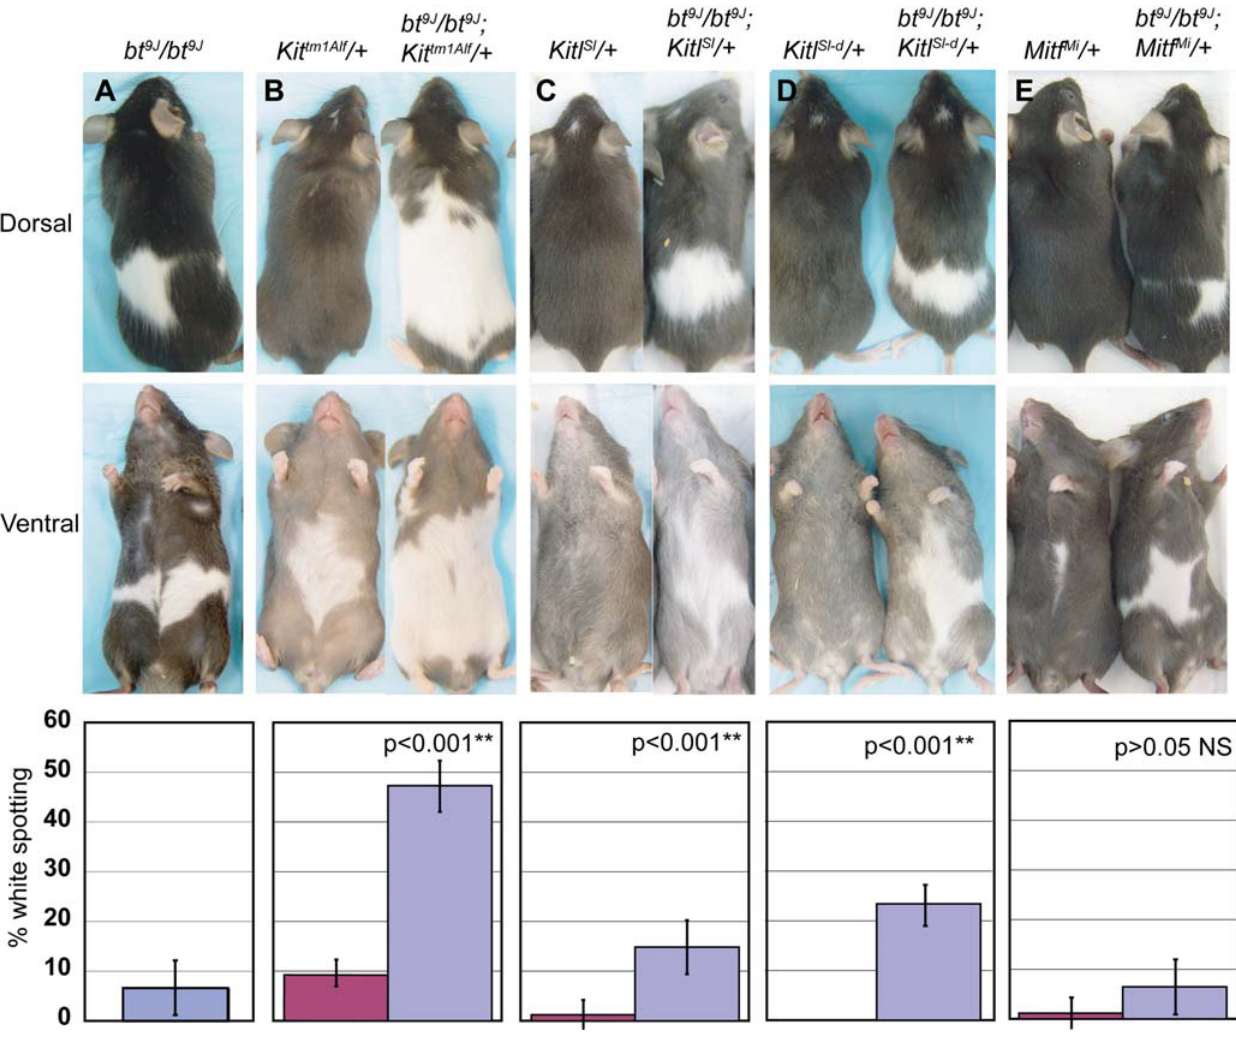
Figure 5. bt 9J /bt 9J animals exhibit synergistic spotting with heterozygous mutations in the Kit pathway. (A–E) Shown are representative dorsal and ventral images of mice (top and middle row, respectively). The genotypes and number of animals (n) analyzed were: (A) bt 9J /bt 9J (n=31), (B) Kit tm1Alf / + (n=14) and bt 9J /bt 9J ;Kit tm1Alf / + (n=15), (C) Kitl Sl / + (n=24) and bt 9J /bt 9J ; Kitl Sl / + (n=17), (D) Kitl Sl-d / + (n=6) and bt 9J /bt 9J ; Kitl Sl-d / + (n=6), and (E) Mitf Mi / + (n=8), and bt 9J /bt 9J ; Mitf Mi / + (n=13). Below are graphs showing quantitation of the average proportion of white spotting with standard deviations. P values represent comparisons of spotting between compound mutants and bt 9J /bt 9J animals, and between compound mutants and Kit mutants. Asterisks indicate highly significant values.